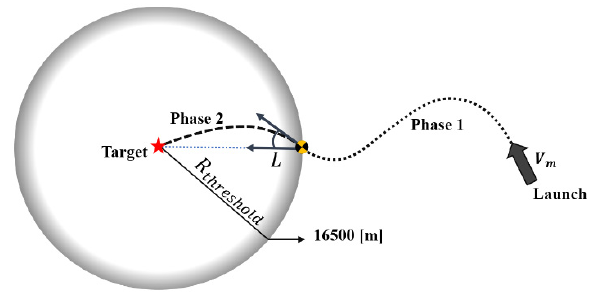
Figure 3. Planar engagement scenario.